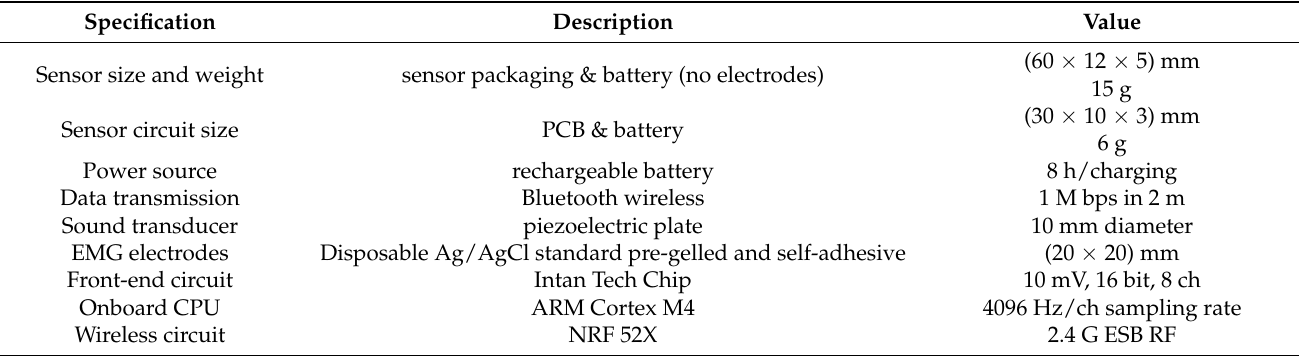
Figure 2. Overall system block diagram. Table 1. The specifications of the wireless wearable health